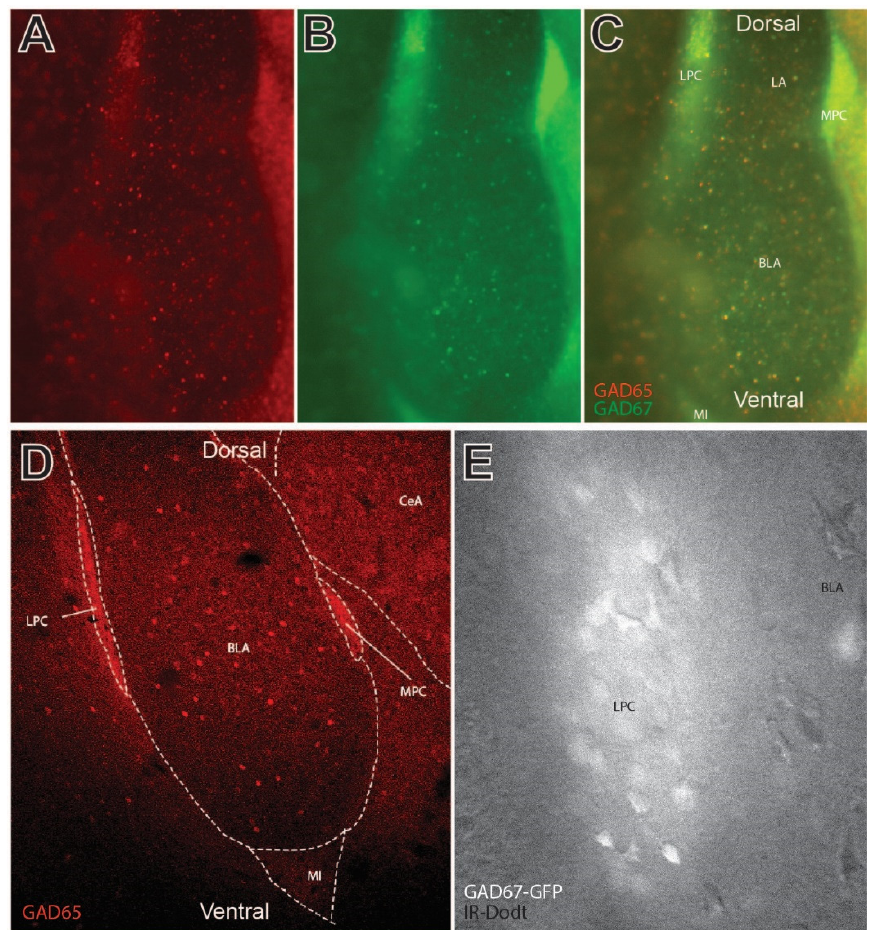
Figure 1. Visualization of GABAergic lateral paracapsular (LPC) neurons of the basolateral amygdala (BLA) in coronal sections. ( A – C ) Widefield fluorescent imaging of GAD65 (mcherry) and GAD67 (GFP)-labeled GABAergic neurons in and around the BLA, lateral amygdala (LA), and central amygdala (CeA). Paracapsular neurons of this region include GABAergic neurons of the LPC, medial paracapsular (MPC), and main island (MI) subregions. GAD65 and GAD67 varied to some degree by cell, though strong colocalization was observed in LPC and MPC neurons. ( D ) Confocal sectional imaging in GAD65 (mcherry)-labeled transgenic mice shows GAD65 labeling of axon collaterals in LPC and MPC clusters. ( E ) High magnification infrared image of the dense LPC neuron cluster as visualized on a patch electrophysiology microscope. Note the strong fluorescent labeling of individual cells and diffuse fluorescence reminiscent of axon collaterals observed in panel D. Fluorescent GFP labeling of GABAergic neurons was used to direct recordings in LPC electrophysiology